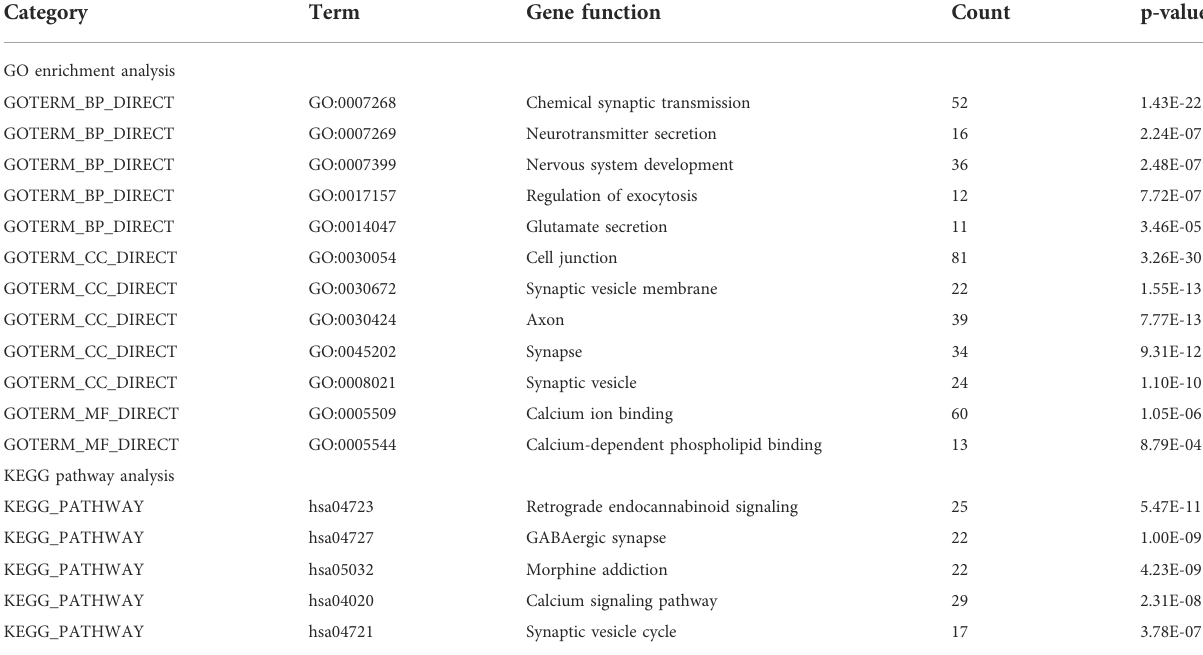
TABLE 2 Top 5 signi fi cantly enriched GO terms and KEGG pathways of DEGs.